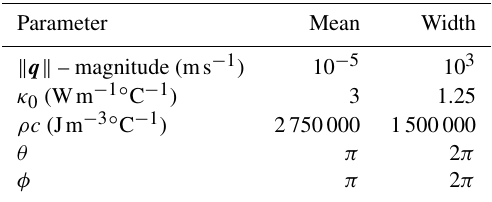
Table 1. Initial parameter values for (cid:107) q (cid:107) , θ , φ , κ 0 and ρc used in the analysis routine. A uniform distribution of the five parameters was